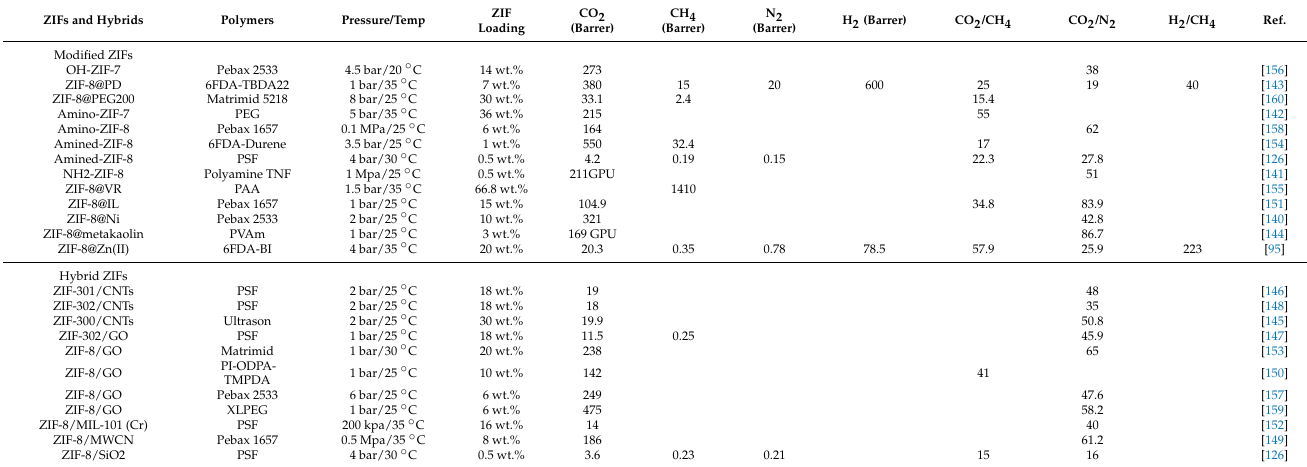
Table 4. Transport properties of modified and/or hybrid ZIF-based mixed matrix membranes. ZIFsandHybrids